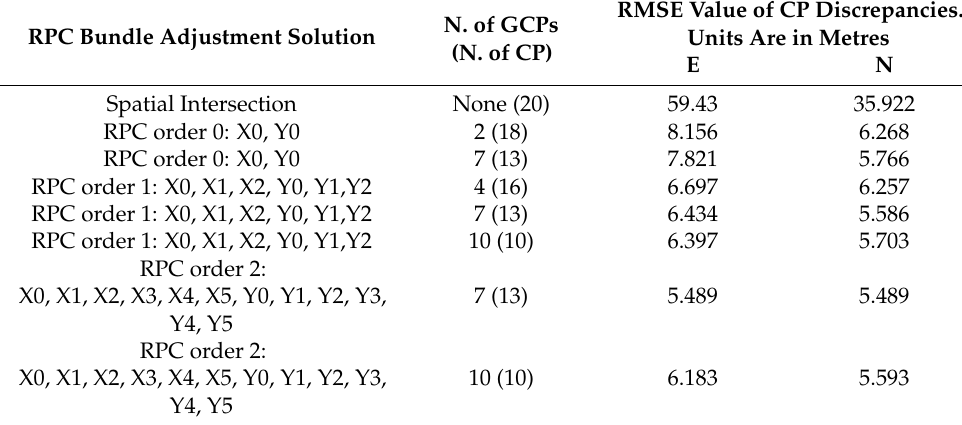
Table 5. Results of RPC bundle adjustment with bias compensation for Ischia test field.